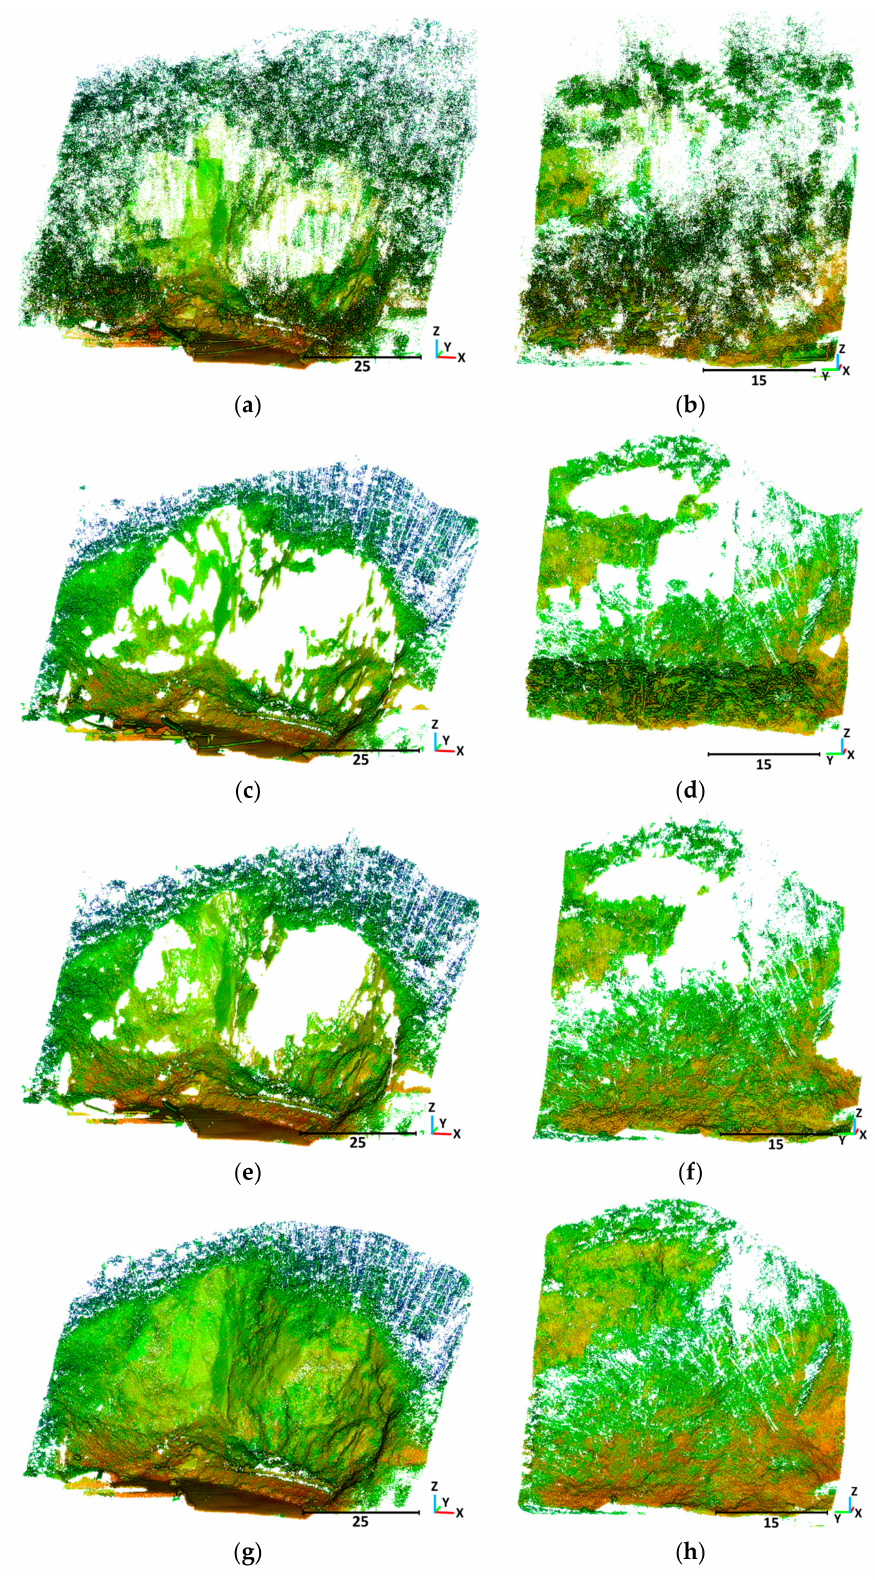
Figure 11. Comparison of filtering results: ( a ) site A and ( b ) site B by ATIN; ( c ) site A and ( d ) site B by WLLI; ( e ) site A and ( f ) site B by CSF; ( g ) site A and ( h ) site B by the proposed